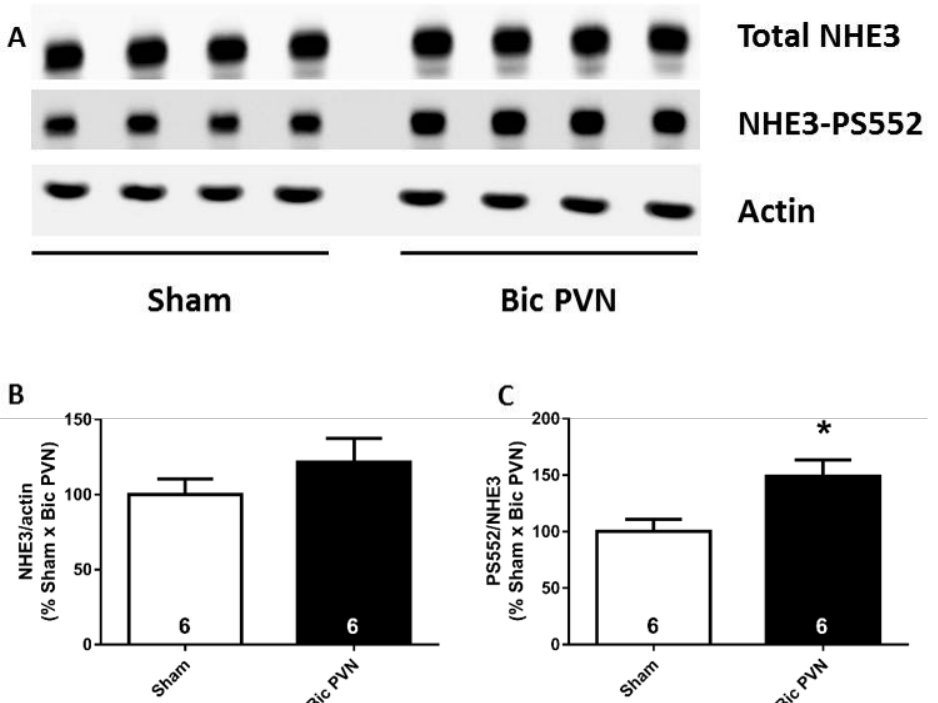
Figure 3. Effect of bicuculline on the paraventricular nucleus of the hypothalamus (Bic PVN) on sodium-hydrogen exchanger isoform 3 (NHE3). ( A ) Blots from the renal cortex of total NHE3, NHE3 phosphorylated at serine 552 (NHE3-PS552), and actin. The total amount of NHE3 corrected by actin did not distinguish between the sham and Bic PVN groups ( B ). Ratio of PS552/total NHE3 was significantly higher in the Bic PVN group ( C ). The number of rats is shown inside the bars. * p < 0.05 compared to sham. Student’s t-test.